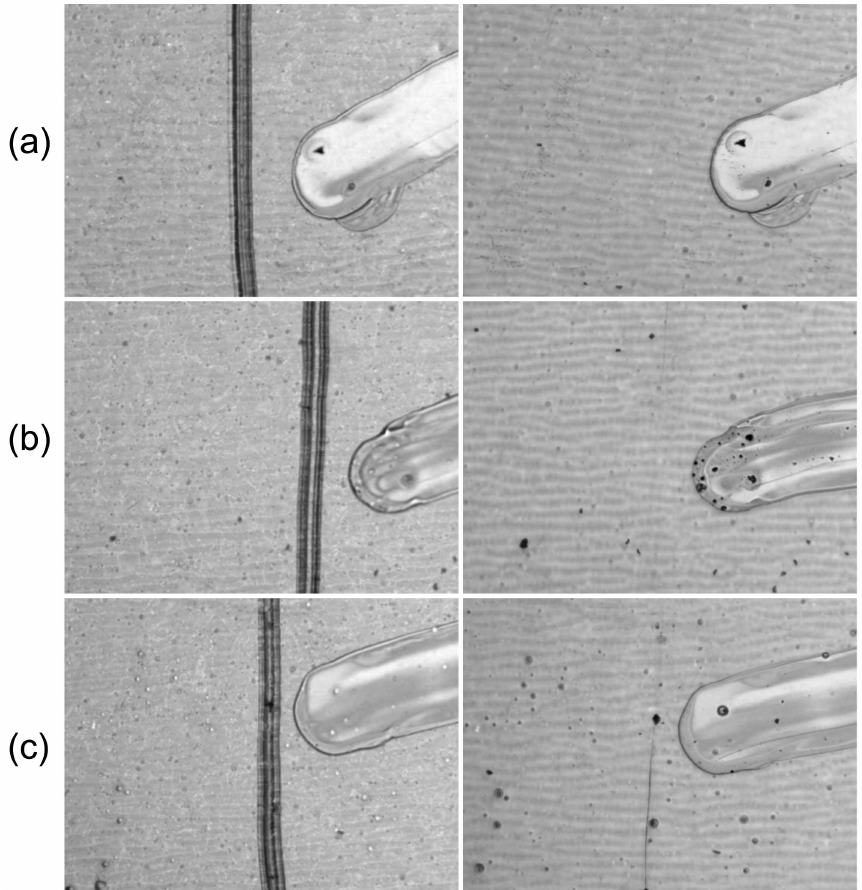
Figure 4. Shape-memory assisted scratch-healing stability of the trilayer composite: optical micro- scope digital photographs at 75 × magnification of ( a ) untreated sample as well as after ( b ) thermal and ( c ) irradiance treatment for 25 h (left) before and (right) after healing process of the scratch produced with constant loading of 1.5